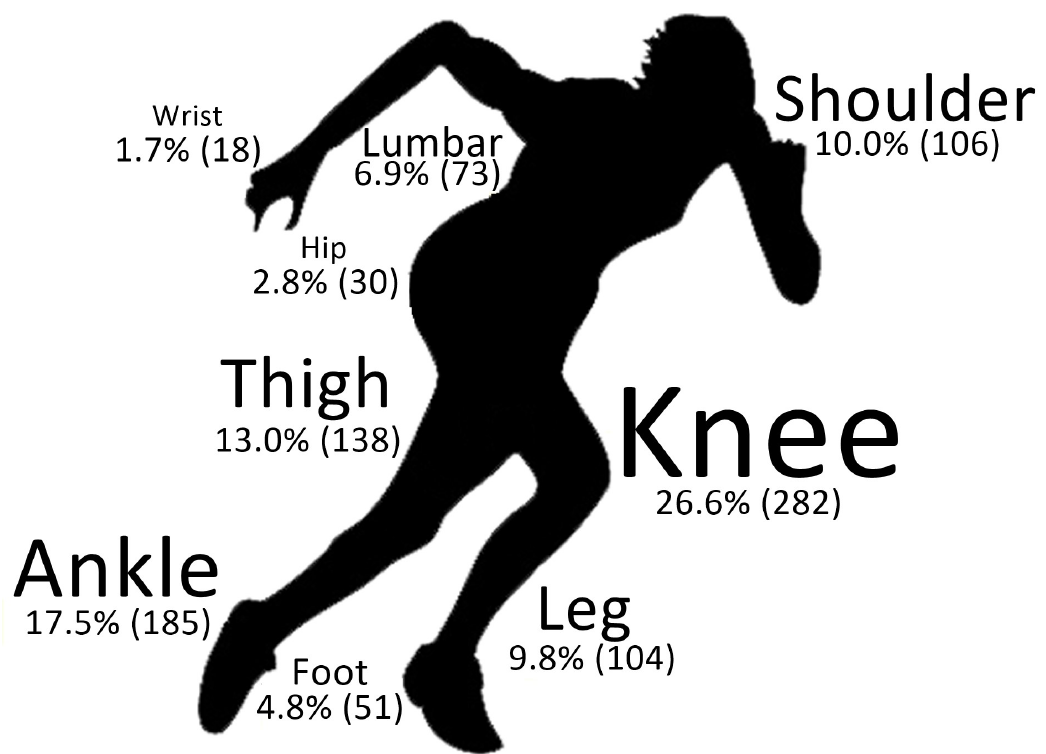
Figure 1 - Incidence of of injuries per body